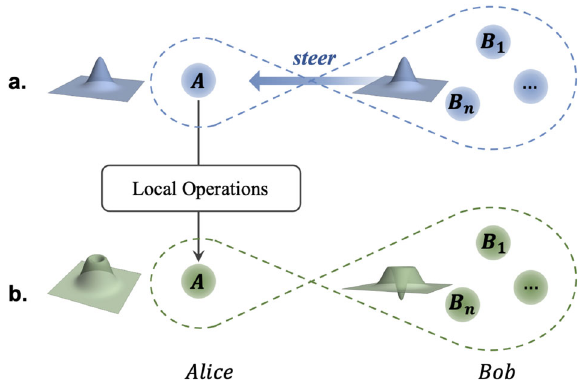
Fig. 1 Scheme of the remote generation of Wigner negativity through EPR steering in a multipartite scenario. a The initial Gaussian steerable system; b After some appropriate local opera- tions on the steered mode hold by Alice, the steering subsystem hold by Bob becomes non-Gaussian with Wigner